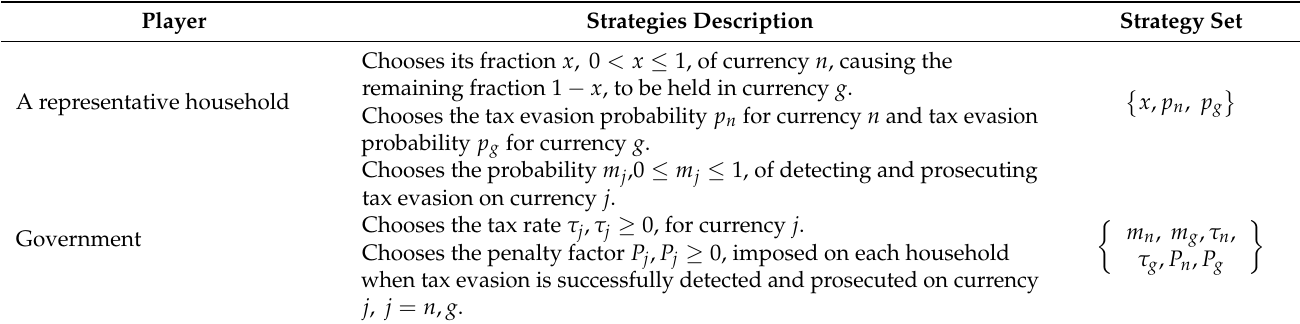
Table 1. Player descriptions and strategy